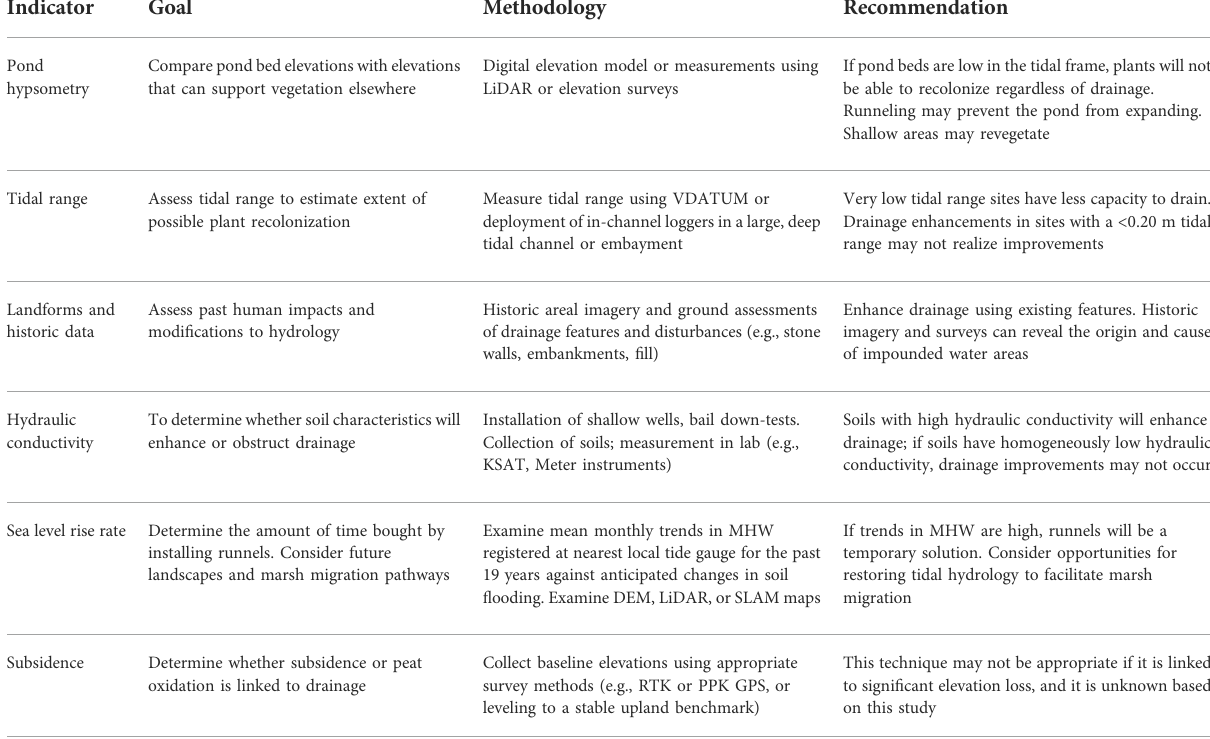
TABLE 3 Assessment indicators and runneling recommendations for restoration